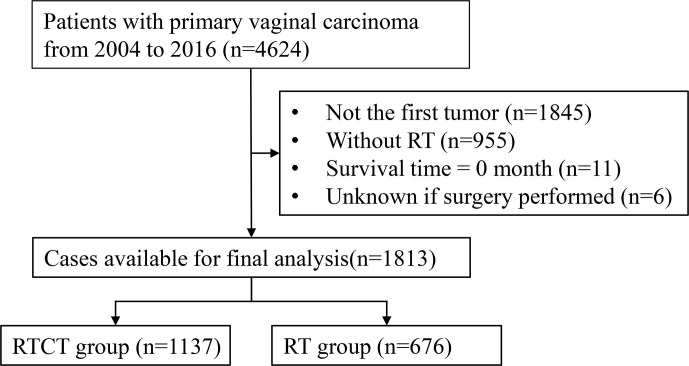
Flowchart of the patient selection procedure. RT, radiotherapy; RTCT, radiotherapy plus chemotherapy.